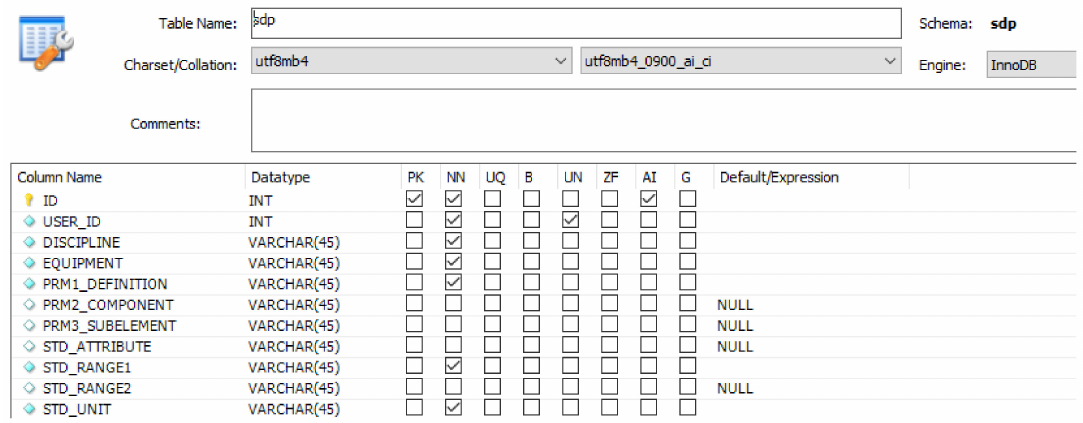
Figure 13. Row setting of the DPE